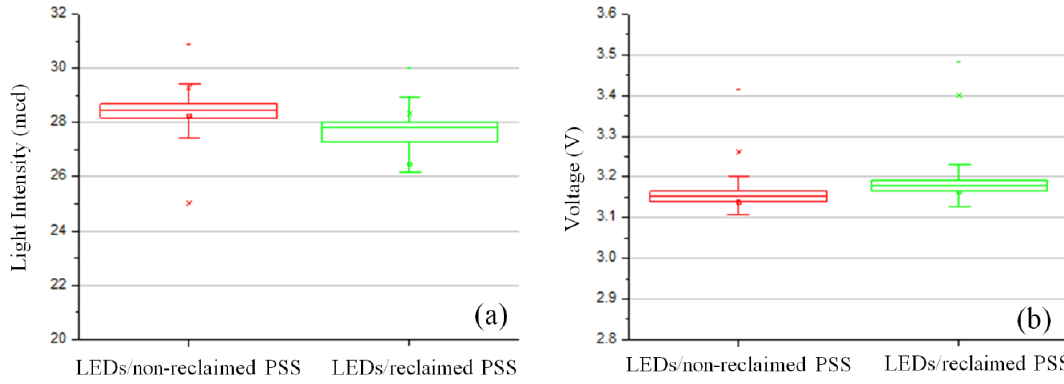
Figure 6. ( a ) Optical and ( b ) electrical performance of both LED types with 20 mA injection current.